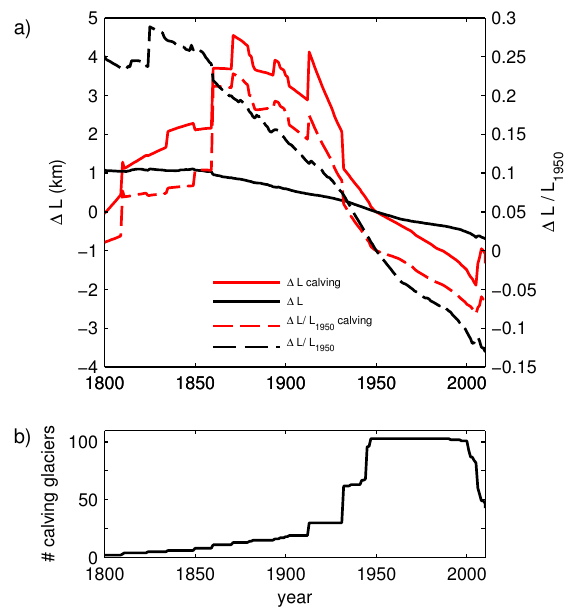
Fig. 10. (a) Global average length change with respect to 1950 of calving glaciers, both tidewater and calving in lakes, (red) and non-calving glaciers (black). The globally averaged relative length change ( 1L divided by the glacier length in 1950) is given in dashed lines for both calving (dashed red) and non-calving (dashed back) glaciers (scale on right axis). (b) Number of calving glaciers in the data set as a function of time. Prior to ± 1860 the number of calving glaciers is very small and the average length change is dominated by the large advance of San Rafael Glacier,